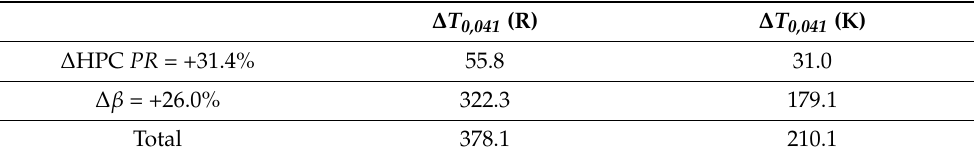
Table 7. Assumption differences vs.